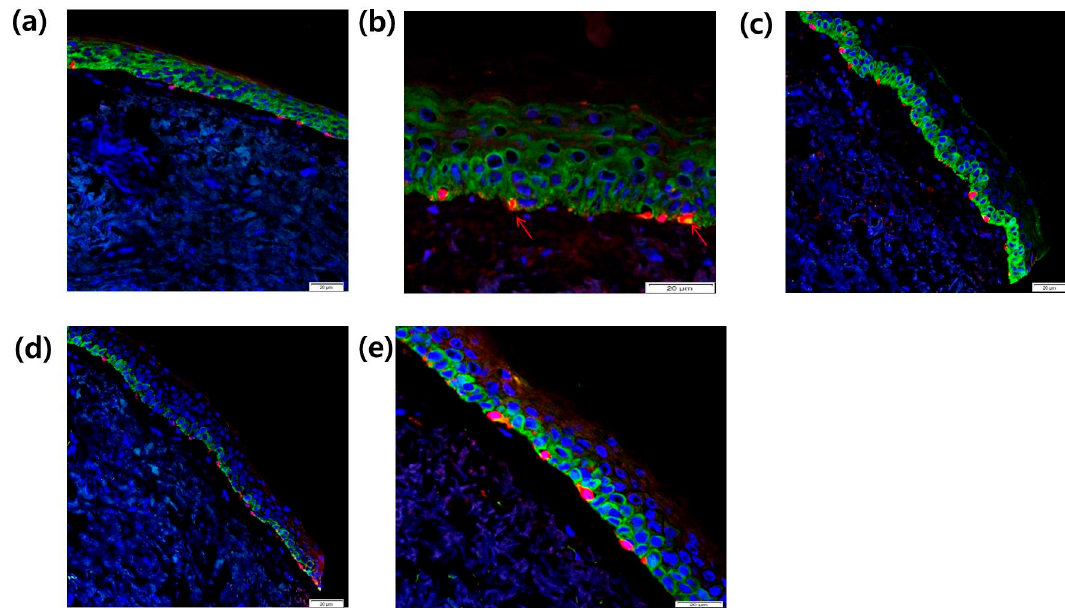
Figure 7. Localization of CCR2 in the epidermis from ( a ) normal skin tissue and ( b ) SL tissue was evaluated by double immunofluorescence staining. Skin tissues were stained with Alexa-Fluor 546-conjugated (for Melan A (red)) secondary antibody for 30 min. The samples were washed, and then incubated with FITC-conjugated goat anti-rabbit IgG secondary antibody against Rb and CCR2 (green) for 30 min at room temperature (scale bar: 20 µm). Yellow and arrow, Melan A-positive melanocytes with CCR2 co-localization; ( c – e ) After DAPI staining, the sections were mounted and the localization of Rb (green), CCR2, and Melan A (red) was detected using a confocal laser scanning microscope (scale bar: 20 µm).